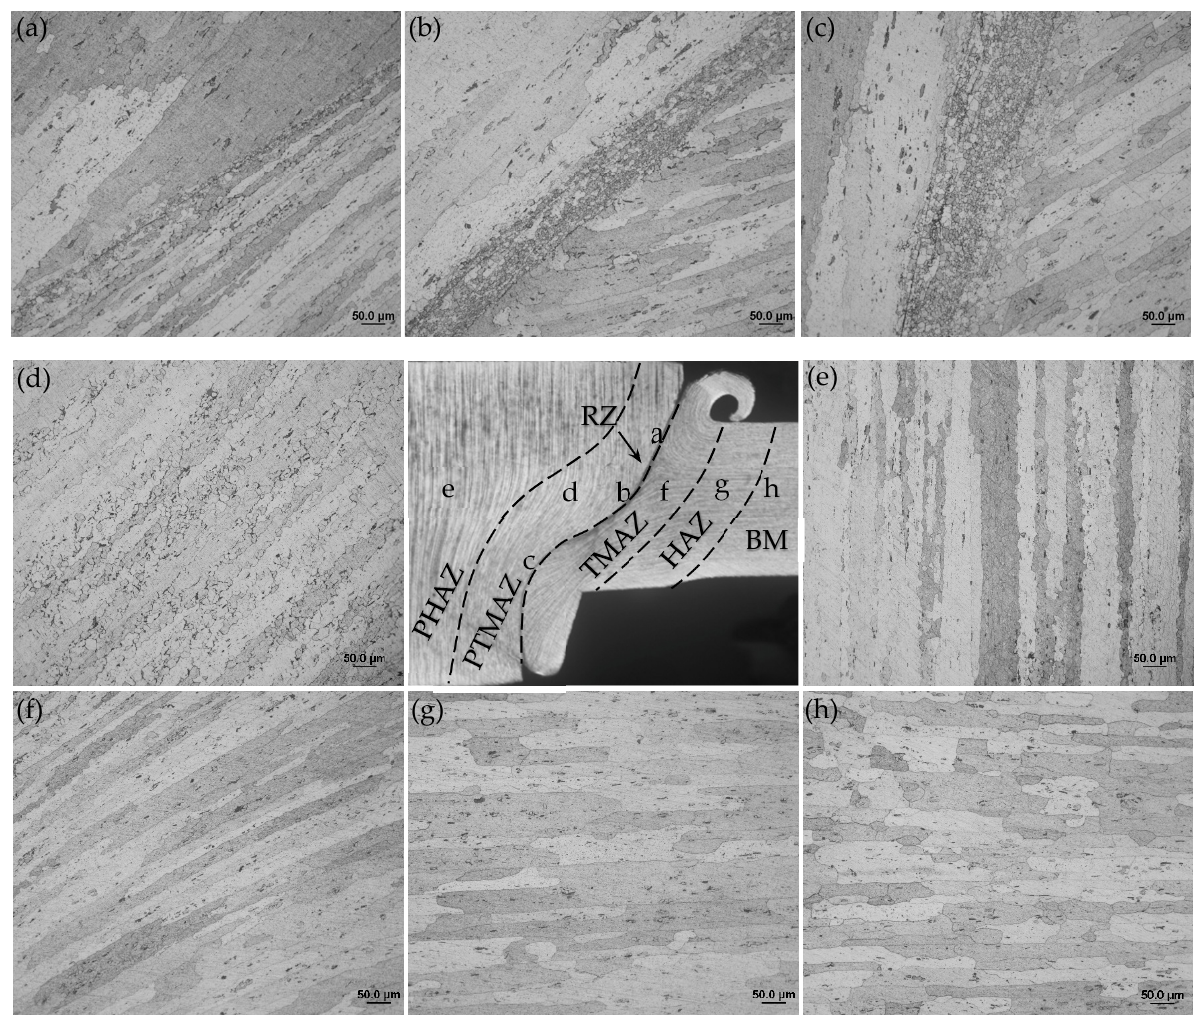
Figure 12. Microstructures of D4 joint along the parallel direction of FSW weld: ( a ) top RZ, ( b ) mid ‐ dle RZ, ( c ) bottom RZ, ( d ) PTMAZ, ( e ) PHAZ, ( f ) NTMAZ, ( g ) NHAZ and ( h ) NZ.